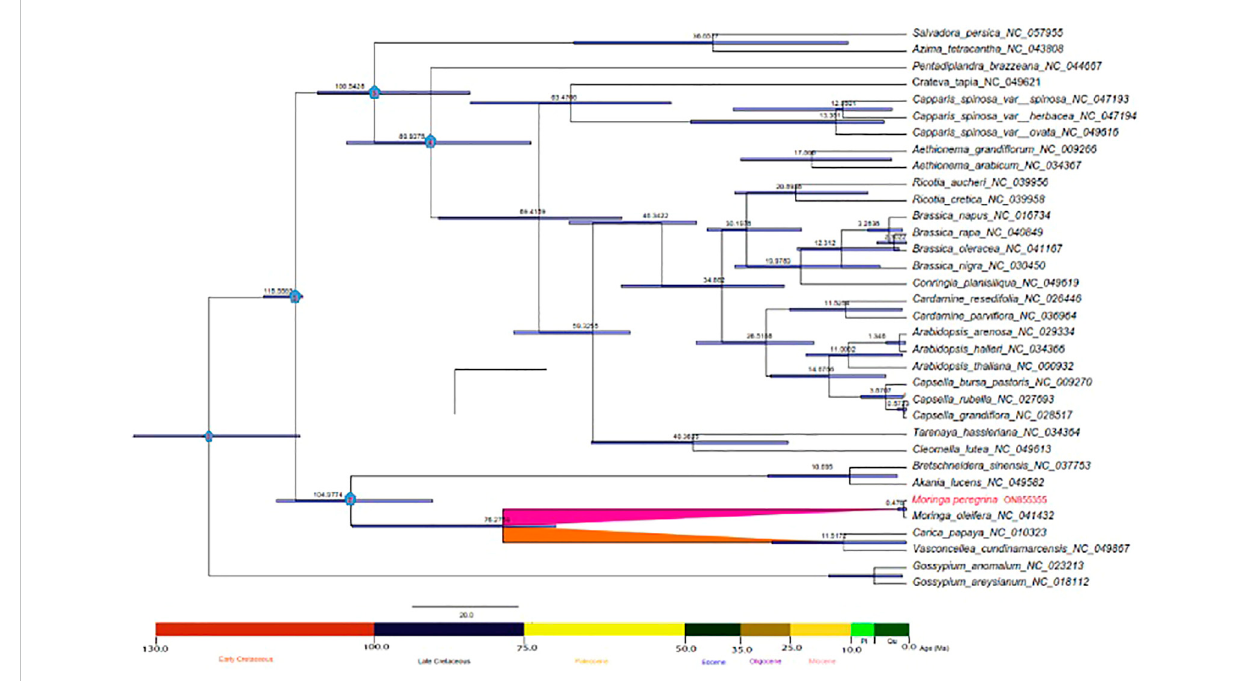
FIGURE 8 PhylogeneticchronogramshowingtheevolutionarydatingtimeoforderBrassicalesusing34taxa.ThetreewasestimatedusingBayesiananalysisof 54 protein-coding genes in the MCMC tree. The number in the circle in red relates to our two nods of